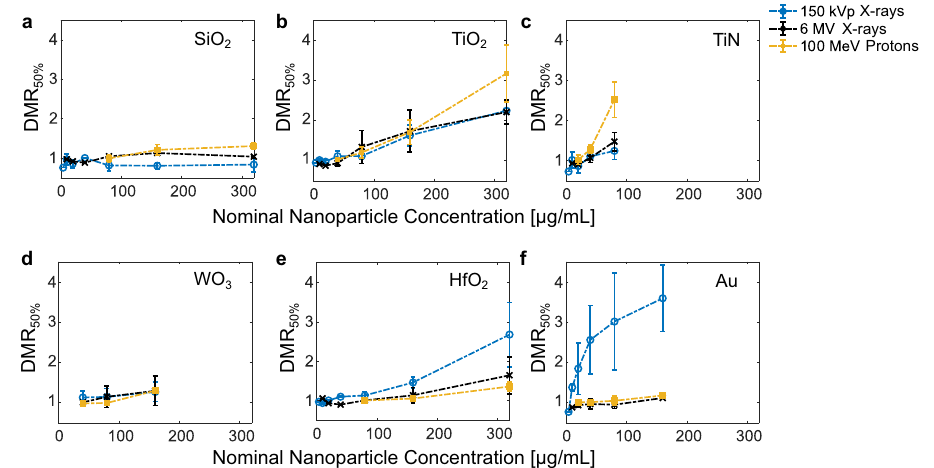
Fig. 5 Nanoparticle radioenhancement in vitro. Dose modifying ratios at 50% cell survival (DMR 50% ) observed in vitro with different nominal nanoparticle concentrations of SiO 2 ( a ), TiO 2 ( b ), TiN ( c ), WO 3 ( d ), HfO 2 ( e ), and Au ( f ) nanoparticles in HT1080 cells; data extracted from survival curve with n = 15 independent biological samples (3 samples per X-ray dose) and expressed as mean ± SD from at least 2 independent